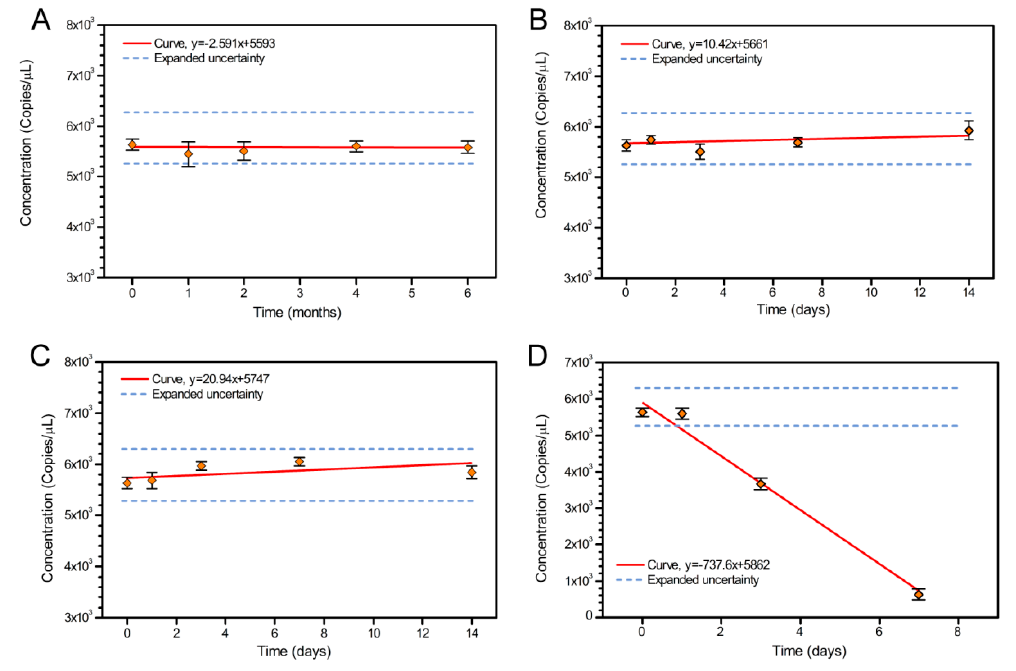
Figure 2. Trends and concentration of stability analysis for the candidate materials: ( A ) long–term stability at − 20 ◦ C and ( B – D ) short–term stability at 4 ◦ C, 25 ◦ C, and 60 ◦ C. The error bars represent the standard deviation of within–bottle triplicate subsamples.